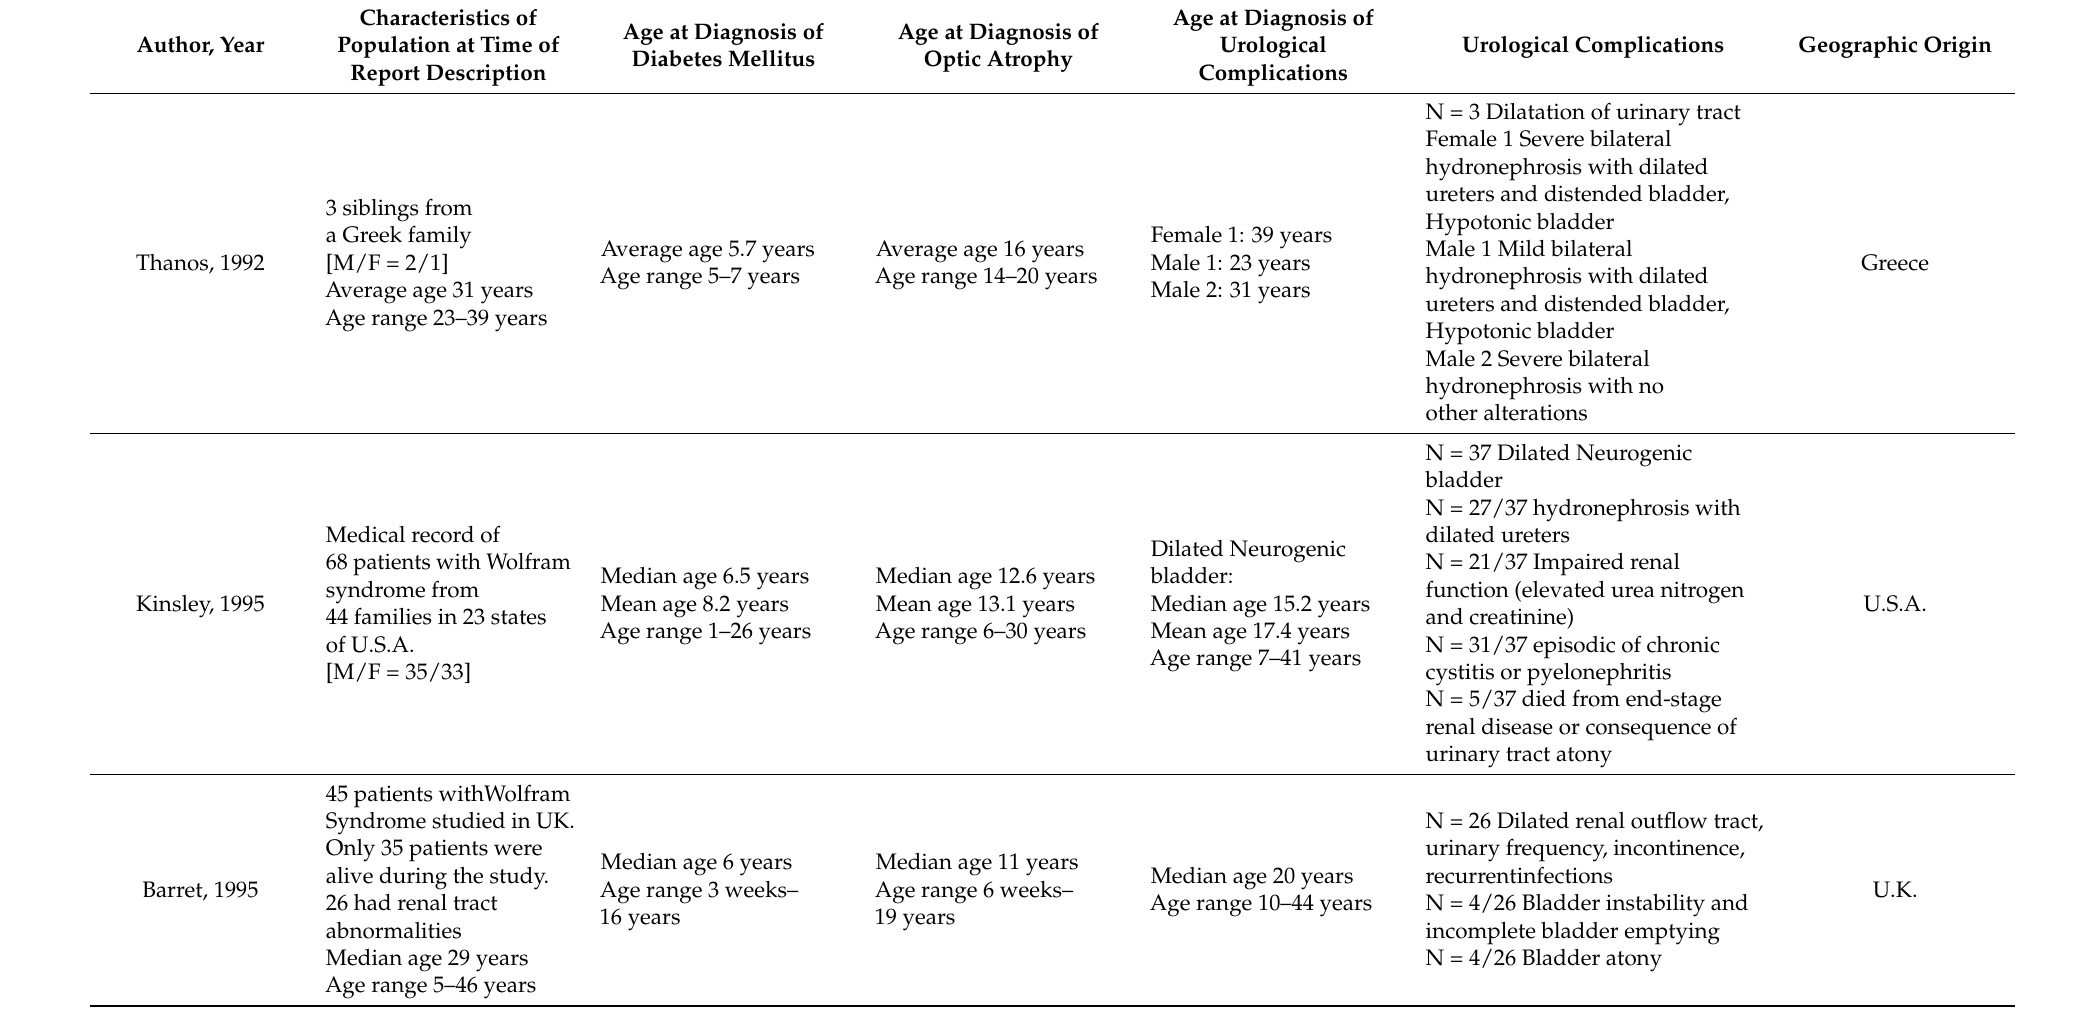
Table 1. Overview of the original articles reporting on renal and urologic involvement in Wolfram